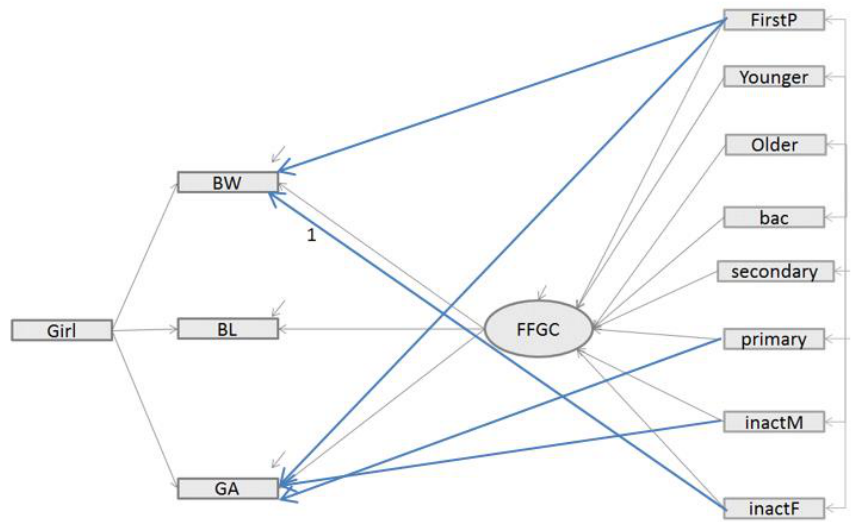
Figure 3. Structural equation model relating parents’ characteristics to those of an infant’s birth (BW, BL, GA) with a mediating latent variable FFGC and additional paths (Model 3). Legend: BW = birth weight; BL = birth length, GA = gestational age; GIRL = newborn is a girl; FirstP = newborn was firstborn; Younger = mother was < 20 years old when pregnant; Older = mother was > 35 years old when pregnant; primary = women with a low education level; secondary = women with a middle education level; bac = women with a high education level; unemployedM = unemployed mother; unemployedF = unemployed father